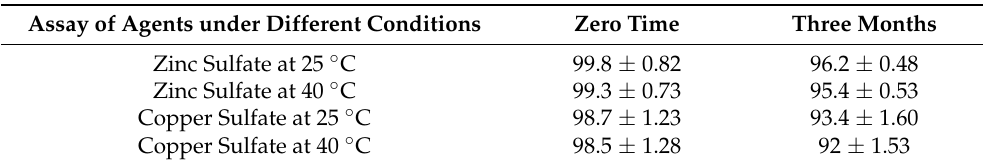
Table 5. Percent zinc sulfate and copper sulfate content in formula F2 at zero time and 3 months at 25 ◦ C and accelerated conditions (40 ± 2 ◦ C/75% ± 5% RH) ( n = 3). Assay of Agents under Different Conditions